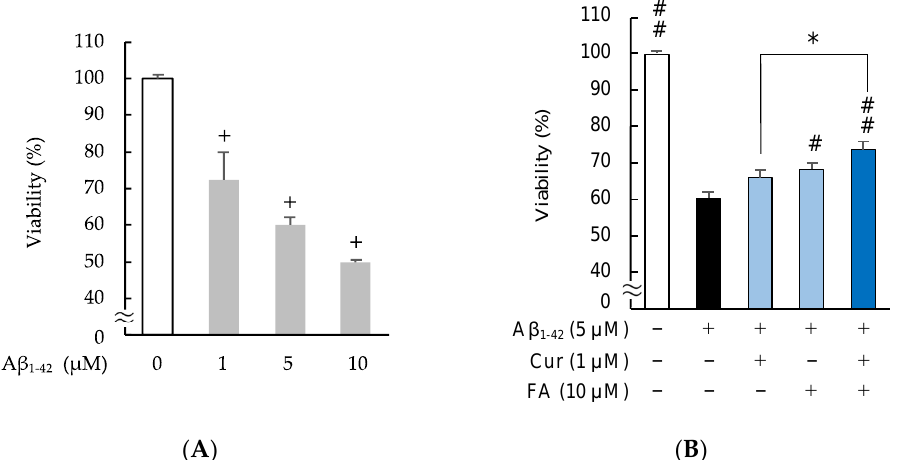
Figure 3. Effect of Cur, FA, or a combination of both on the viability in Aβ 1 – 42 -stimulated SH-SY5Y cells. The viability in Aβ 1 – 42 -stimulated SH-SY5Y cells was evaluated using MTT assay. ( A ) Cell via- bility of SH-SY5Y cells exposed to 5 μM Aβ 1 – 42 (1, 5 and 10 µM) for 3 h. ( B ) Cell viability of SH-SY5Y cells exposed to 5 μM Aβ 1 – 42 and treated with Aβ 1 – 42 + 1 μM Cur, Aβ 1 – 42 + 10 μM FA or Aβ 1 – 42 + Cur + FA for 3 h. +: inclusion of 5 μ M A β 1 ̶̶ 42 , 1 μ M Cur, 10 μ M FA, respectively, − : non-inclusion. The p - values in ANOVA were < 0.001. Each value expresses the mean + S.E.M. of at least 3 independent experiments. In the absence of 5 μM Aβ 1 – 42 , viabilities of control, 1 μM Cur, 10 μM FA and Cur + FA-treated cells were 100.0 ± 1.081, 102.2 ± 2.85, 98.6 ± 2.20 and 103.4 ± 2.00% (no significant differ- ence, n = 6, Tukey). +, p < 0.01 for control versus Aβ 1 – 42 exposed cells (n = 6, Dunnet’s ); #, p < 0.05; ##, p < 0.01 for Aβ 1 – 42 exposed cells versus the other treated cells (n = 6, Tukey); * p < 0.05 for Aβ 1 – 42 + Cur + FA-treated cells versus Cur-treated cells (n = 6, Tukey).